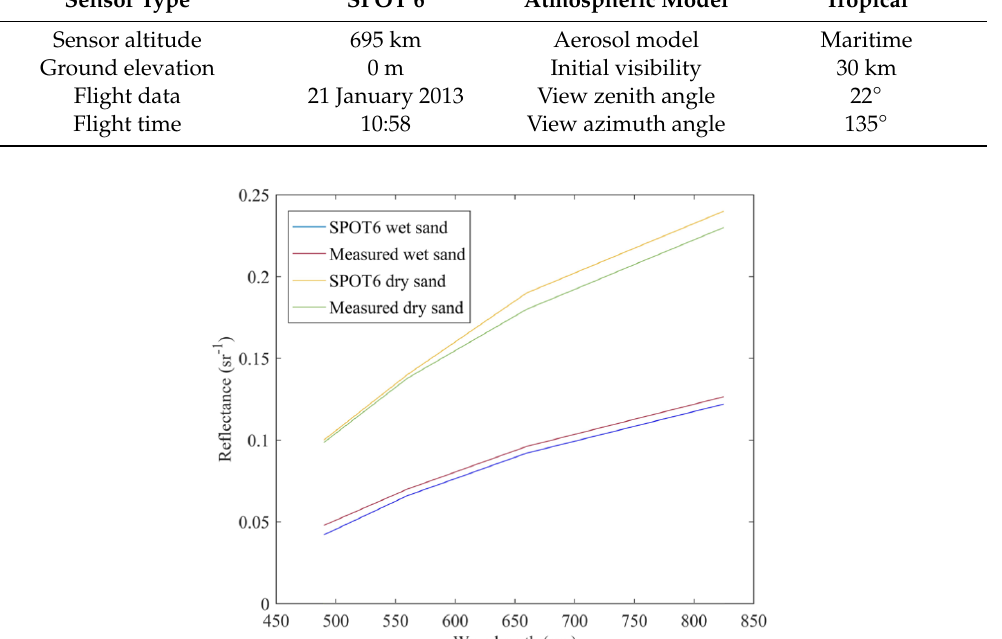
Figure 5. The comparison of the sand remote sensing reflectance of SPOT6 data and the measured data.